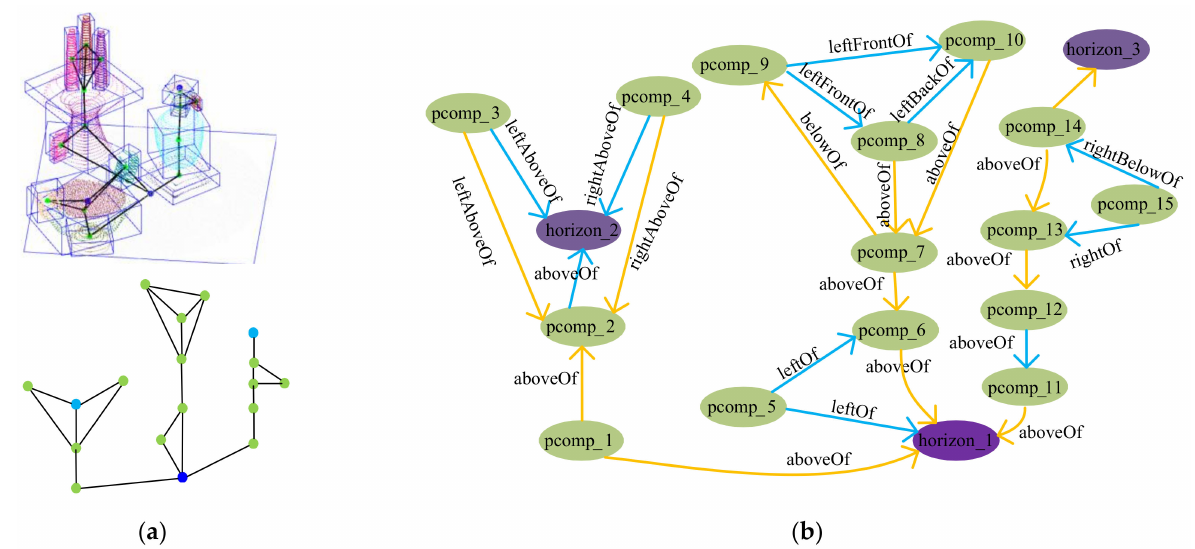
Figure 10. SGSR of a scene: ( a ) The tabletop scene and the relationships graph of scene; ( b ) SGSR of